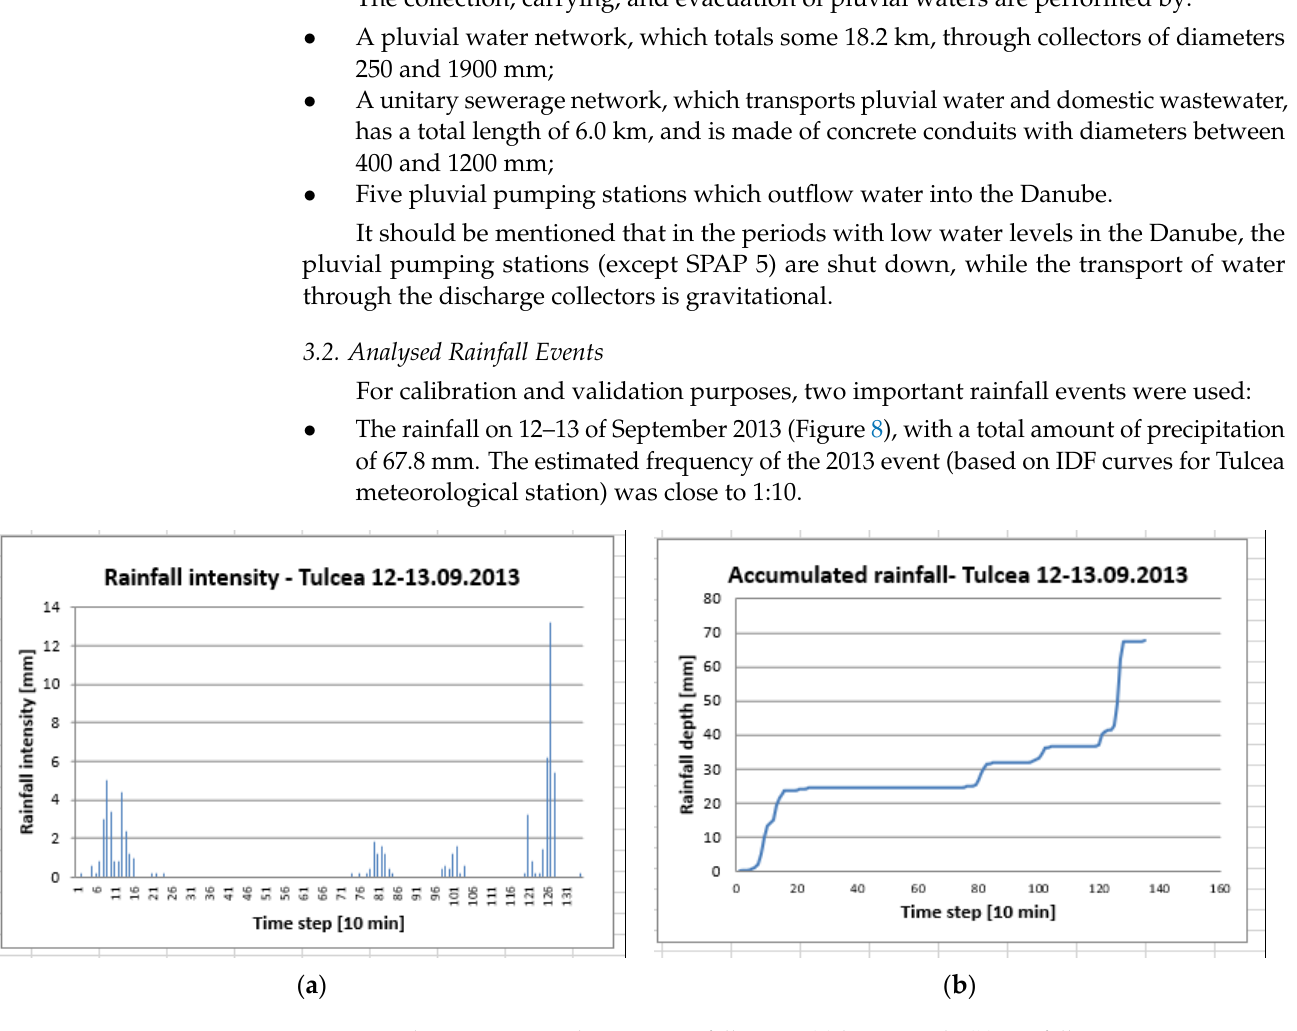
Figure 8. The 12–13 September 2013 rainfall event: ( a ) hyetograph; ( b ) rainfall mass